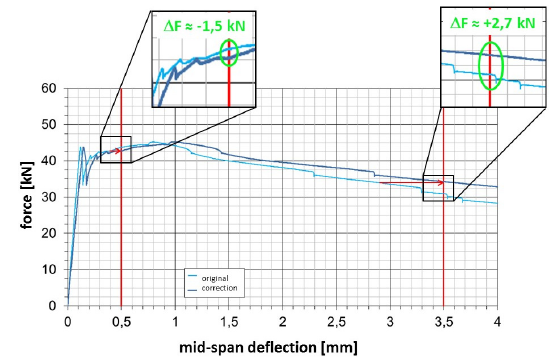
Figure 4. Change of mid-span deflection in case of strain hardening material at low deflections and strain softening at high